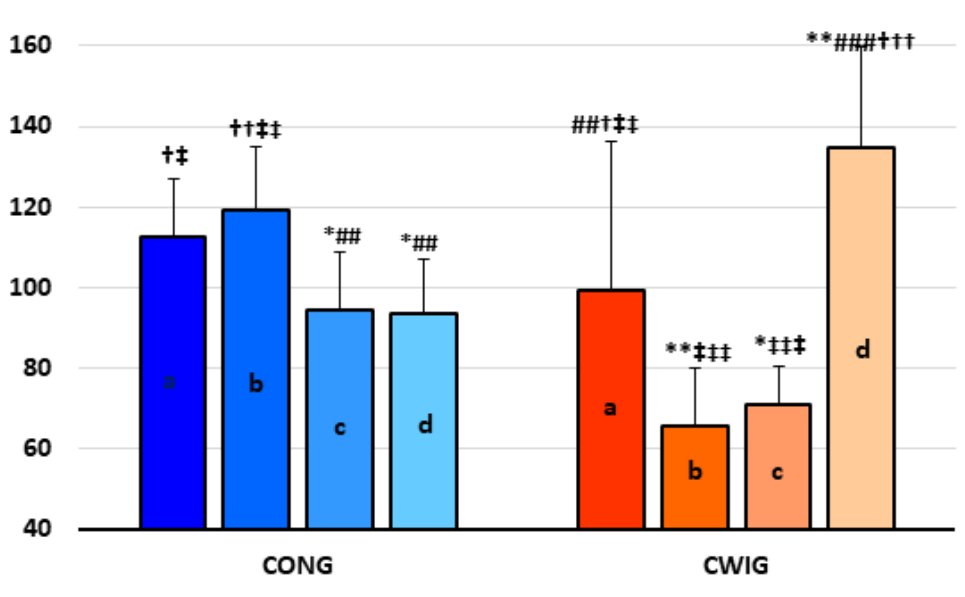
Table 4. Change in glutathione peroxidase (GPX) concentration after CWI (unit/ µ mol). Group CONG CWIG Time